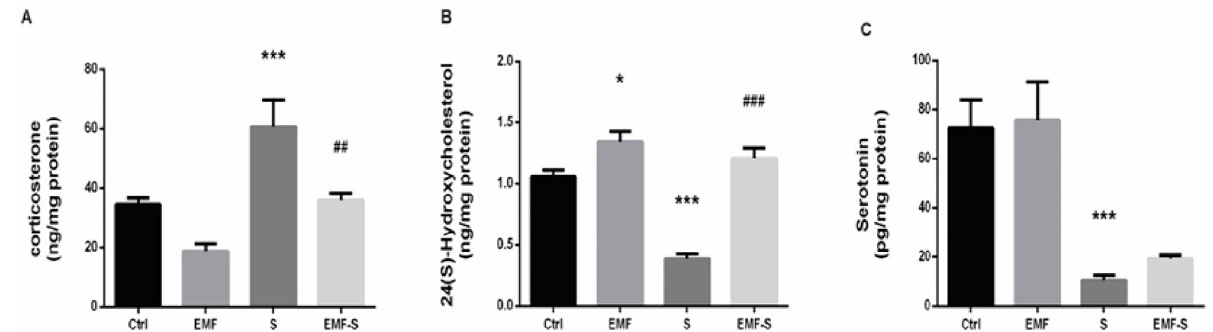
Fig 2. Effect of EMF on hippocampal neurostroids and serotonin levels after prenatal stress. Graphs show the level of (A) corticosterone, (B) 24(S)- OH cholesterol and (C) serotonin. Data are shown as mean ± SEM (n = 6 per group). Two-way ANOVA, followed by Tukey’s post-hoc test: � p < 0.05, ��� p < 0.001 versus control group; ##p < 0.001; ###p < 0.001 versus stress group. ANOVA, analysis of variance; Ctrl, Control; EMF, Electromagnetic Field; S, Stress.